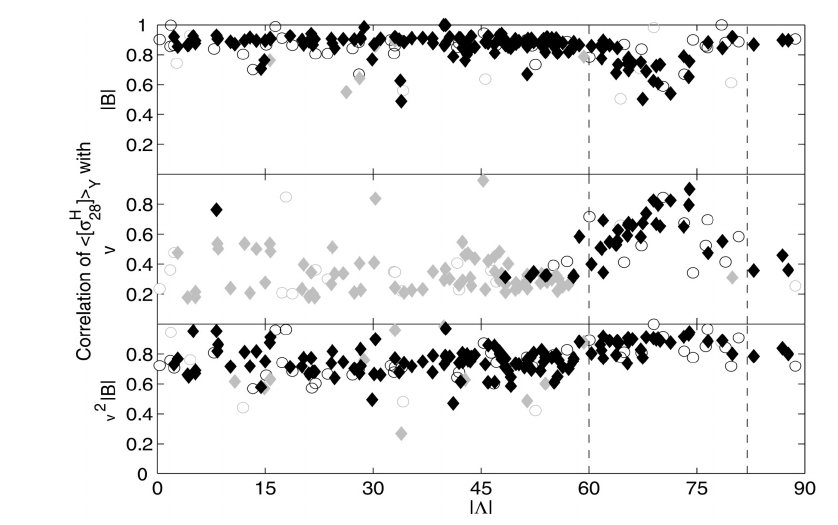
Figure 12: Correlation coefficients of the annual means of the coupling functions (top) IMF magnitude 𝐵 with 𝜎 𝐻 indices from a variety of magnetic observatories, shown 𝐵 , (middle) 𝑉 SW , and (bottom) 𝑉 2 28 SW as a function of the modulus of their invariant magnetic latitude | Λ | . Solid diamonds are for northern hemisphere stations and open circles for southern. Black and grey symbols are for correlations that are significant at the 2 𝜎 and 1 𝜎 levels, respectively. The vertical dashed lines show the auroral oval between (cid:176) (cid:176) absolute invariant latitudes of 60 and 82 . Image reproduced by permission from Finch et al. (2008), copyright by AGU.